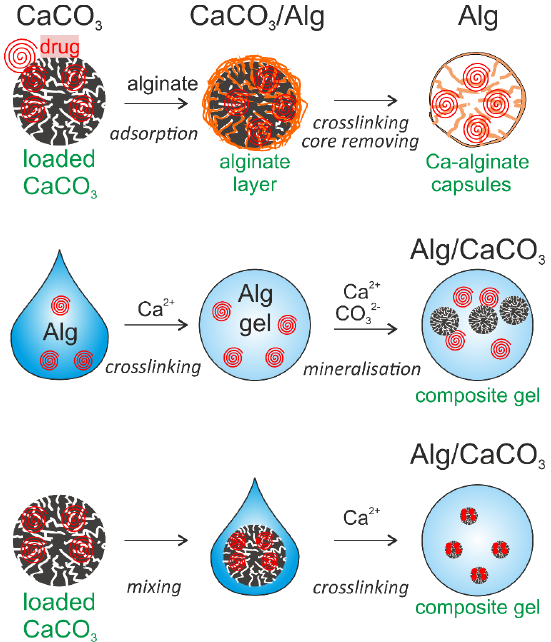
Figure 10. Various possibilities of combining CaCO 3 particles and Alg, including ( A ) using CCPs as a template; ( B ) crosslinking Alg gels by a mineralization process; and ( C ) crosslinking Alg gels into a composite gel.